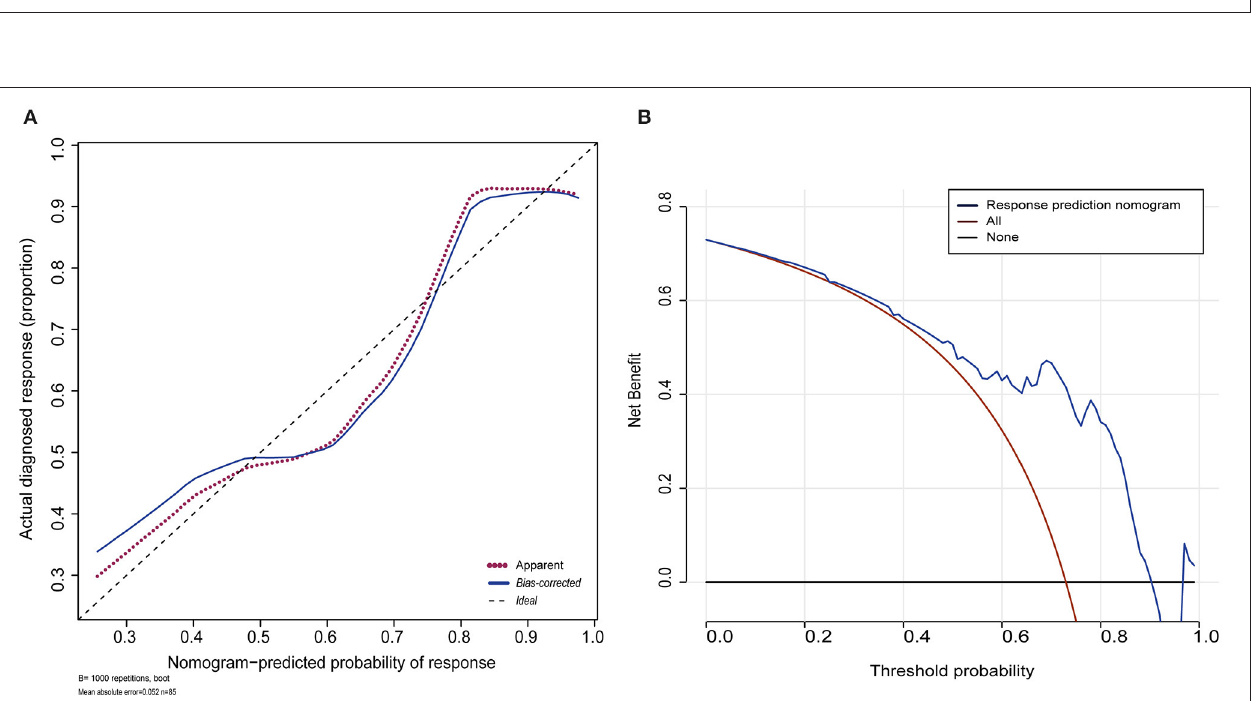
FIGURE 3 | The development of a predictive nomogram for MDD response. A response predicting nomogram was developed in the study cohort that included MCP1, VCAM1, and Lipocalin. First, it is necessary to locate the patient’s MCP1, VCAM1, and Lipocalin level, on the corresponding axis. The score for each value is then assigned by drawing a line upwards to the line, and the sum of the three scores is plotted on the total points line. Next, a line should be drawn straight down to identify the patient’s probability of achieving a response.